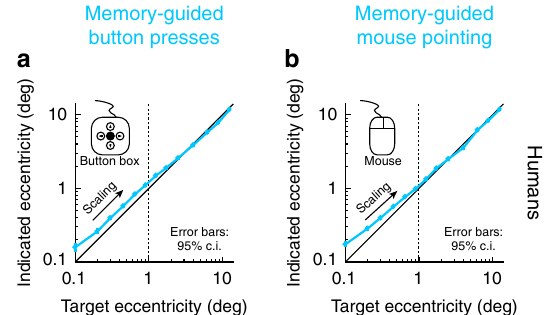
Fig. 5 Overshoot was not restricted to microsaccades; perceptual localization of foveal remembered targets was also expanded in an illusory manner. a In humans, we tested perceptual localization of remembered target locations without explicitly requiring an eye movement response.